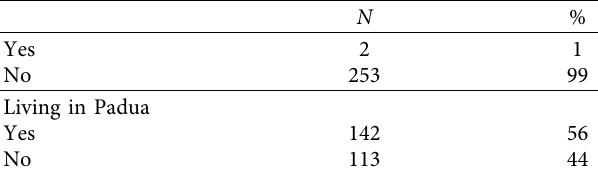
Table 4: Socioeconomic information of the sample.